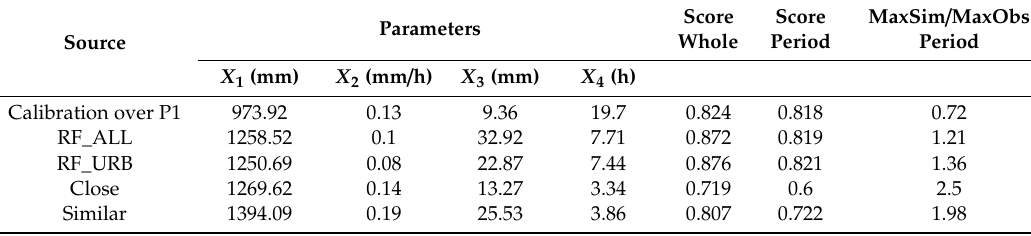
Figure 6. Observed hourly flow time series (in m 3 / s) and simulated flow using parameters transferred from calibration over P1, estimated parameters using RF_ALL and RF_URB, and transferred parameters from the closest and the most similar catchment to the Suwanee Creek catchment (U.S. Geological Survey (USGS) code: 02334885), as response to measured precipitations (in mm / h) between 1 March and 31 August 2013. The sets of parameters correspond to KGESR. Table 3. Sets of parameters transferred from calibration over P1, estimated using RF_ALL and RF_URB, and transferred from the closest catchment and the most similar catchment for the Suwanee Creek catchment. Score Whole is the KGESR over the period 2 (i.e., between 2010 and 2017) and Score Period is computed over the 6-months period for which the resulting hydrographs are shown in Figure